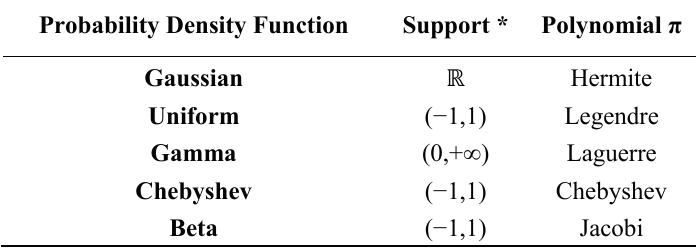
Table 1. Correspondence between classic probability density functions (pdfs) and families of orthogonal